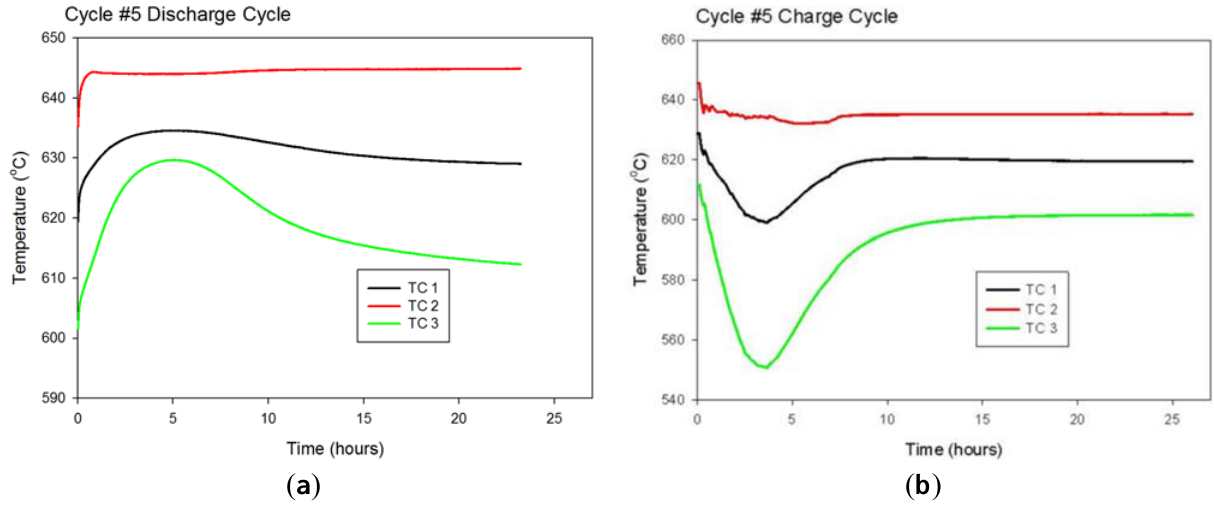
Figure 19. Wall temperatures for three thermocouples TC1, 2 and 3 with time for ( a ) discharging and ( b ) charging for the fifth cycle